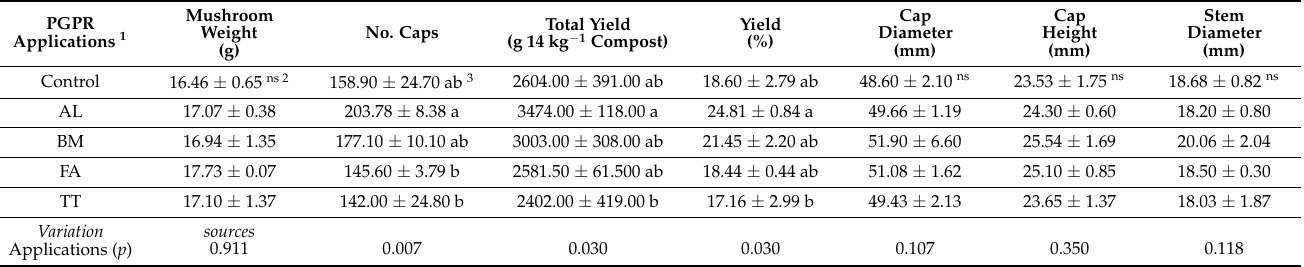
Table 1. Mushroom weight, total yield and yield percentage, cap diameter and height and stem diameter were determined before storage